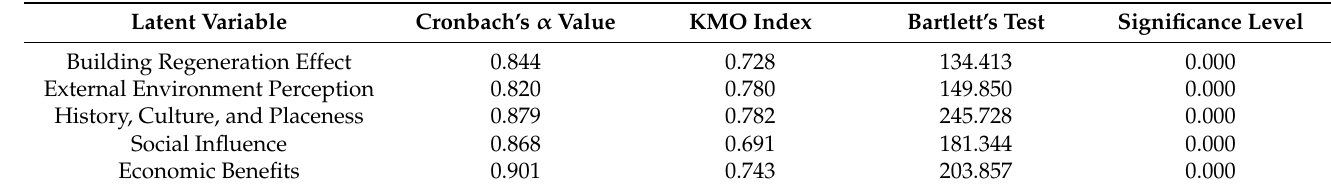
Table 2. Cronbach’s alpha reliability test value.